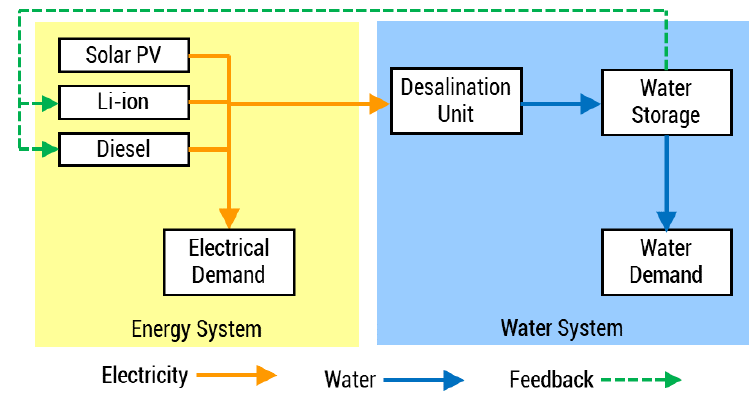
Figure 5. Architecture of the coupled energy and water system.